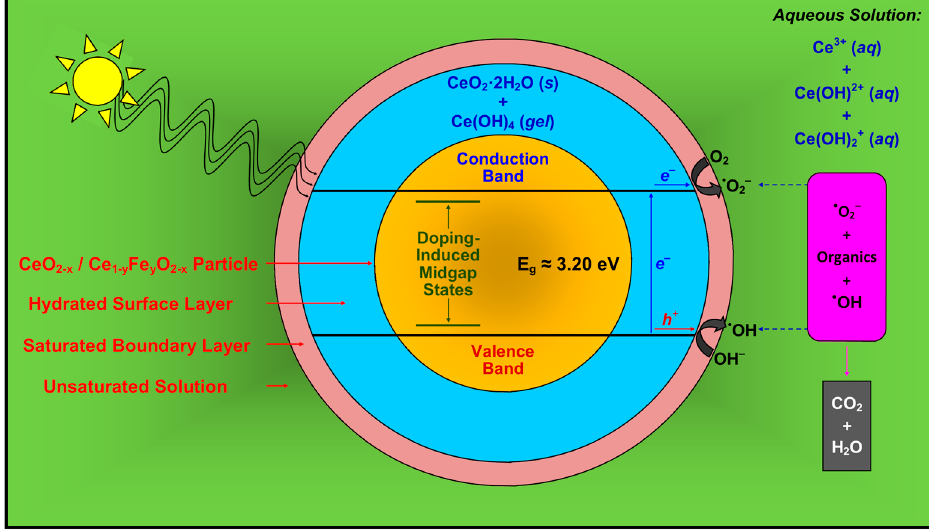
Figure 12. Simplified schematic of Mechanism 7 for the activation of CeO 2 or Fe-doped CeO 2 photocatalyst and the decomposition of organic species, where photocatalysis occurs at the outer surface of the hydrated surface layer of solid CeO 2 ·2H 2 O and gelled Ce(OH) 4 .